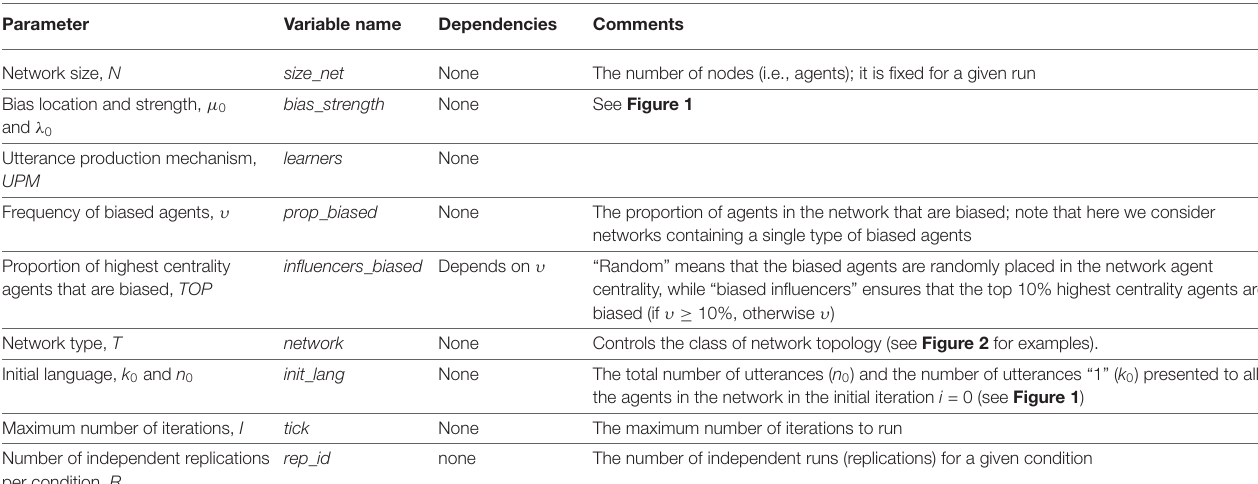
TABLE 1 | Parameters defining our simulations (see also Table 2